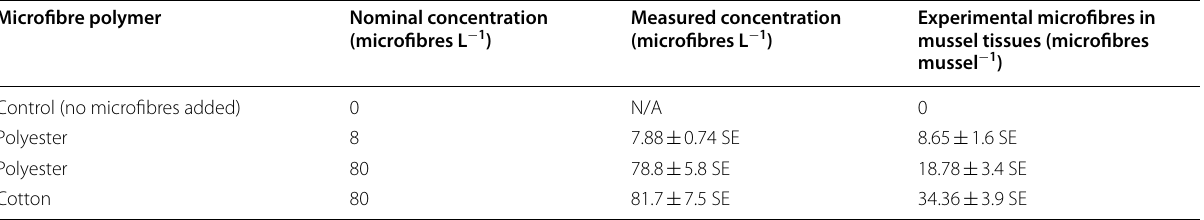
Table 1 Nominal and measured microfibre concentrations in aquaria for each condition and mean experimental microfibres identified in digested mussel soft tissues following exposure experiment